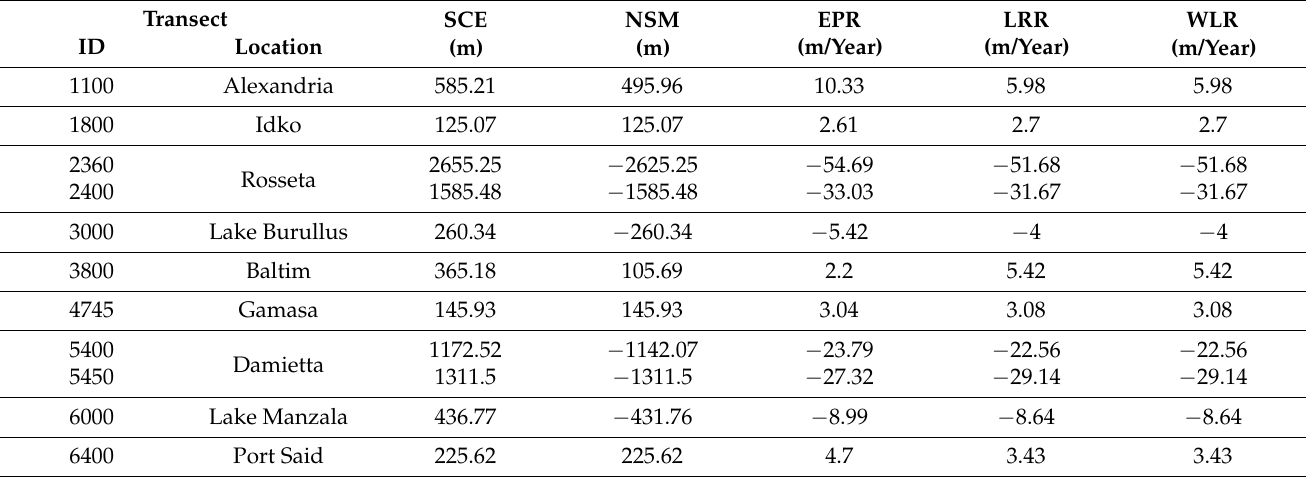
Table 2. The results of statistical measures in the Nile Delta.